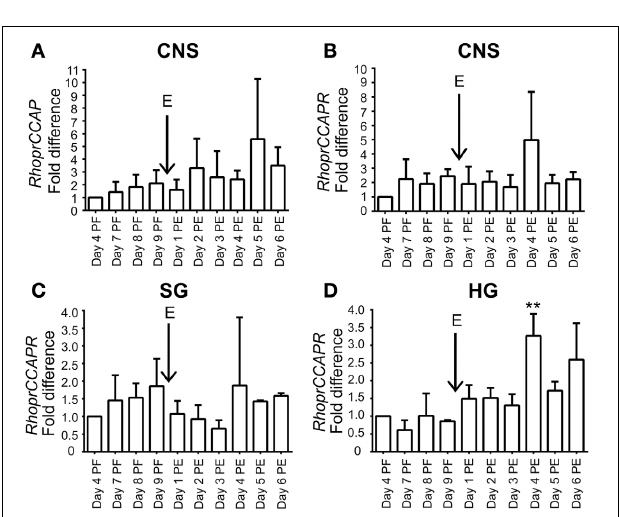
FIGURE 2 | Expression profile of RhoprCCAP and RhoprCCAPR transcript levels during development in different tissues of 4th and 5th instar R. prolixus . (A) RhoprCCAP expression level in central nervous system (CNS). E represents day of ecdysis. (B) RhoprCCAPR transcript expression level in CNS. (C) RhoprCCAPR transcript expression in salivary gland (SG). (D) RhoprCCAPR transcript expression in hindgut (HG) was significantly increased Day 4 post-ecdysis (Day 4 PE) compared to Day 4 post-fed (Day 4 PF) as determined by ANOVA ( P < 0 . 0004; Tukey’s Test ∗∗ P < 0 . 01). Values are expressed as the mean ± s.e.m. ( n = 3).